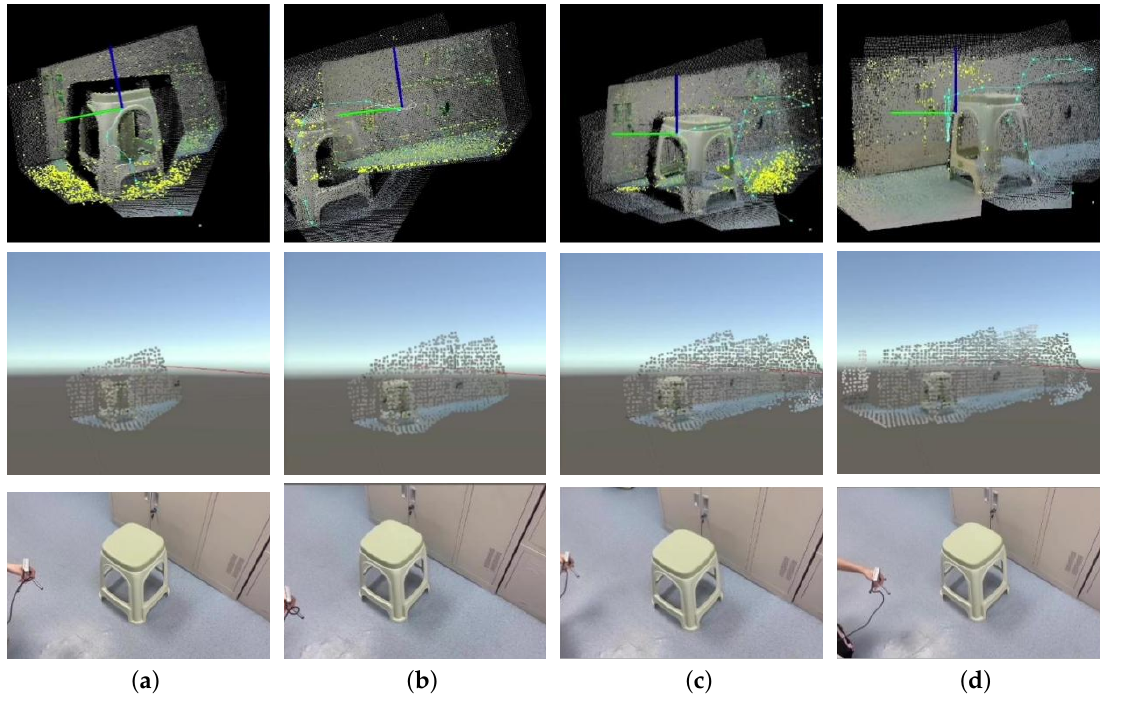
Figure 6. Simulation and experiment results of the SLAM and 3D reconstruction. The first row shows the real-time SLAM results in RTAB-Map-viz. The second row shows the real-time 3D point cloud reconstructed in Unity 3D. The third row shows the pose of the handheld Intel RealSense